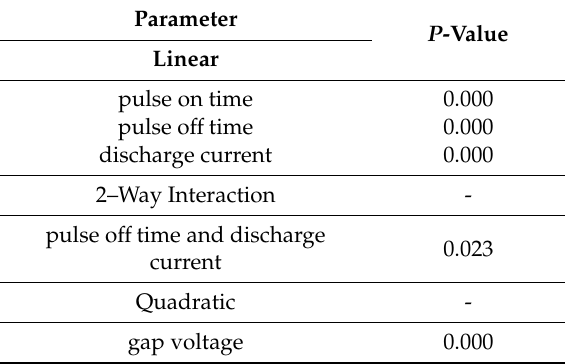
Table 3. P-values of statistically significant parameters.